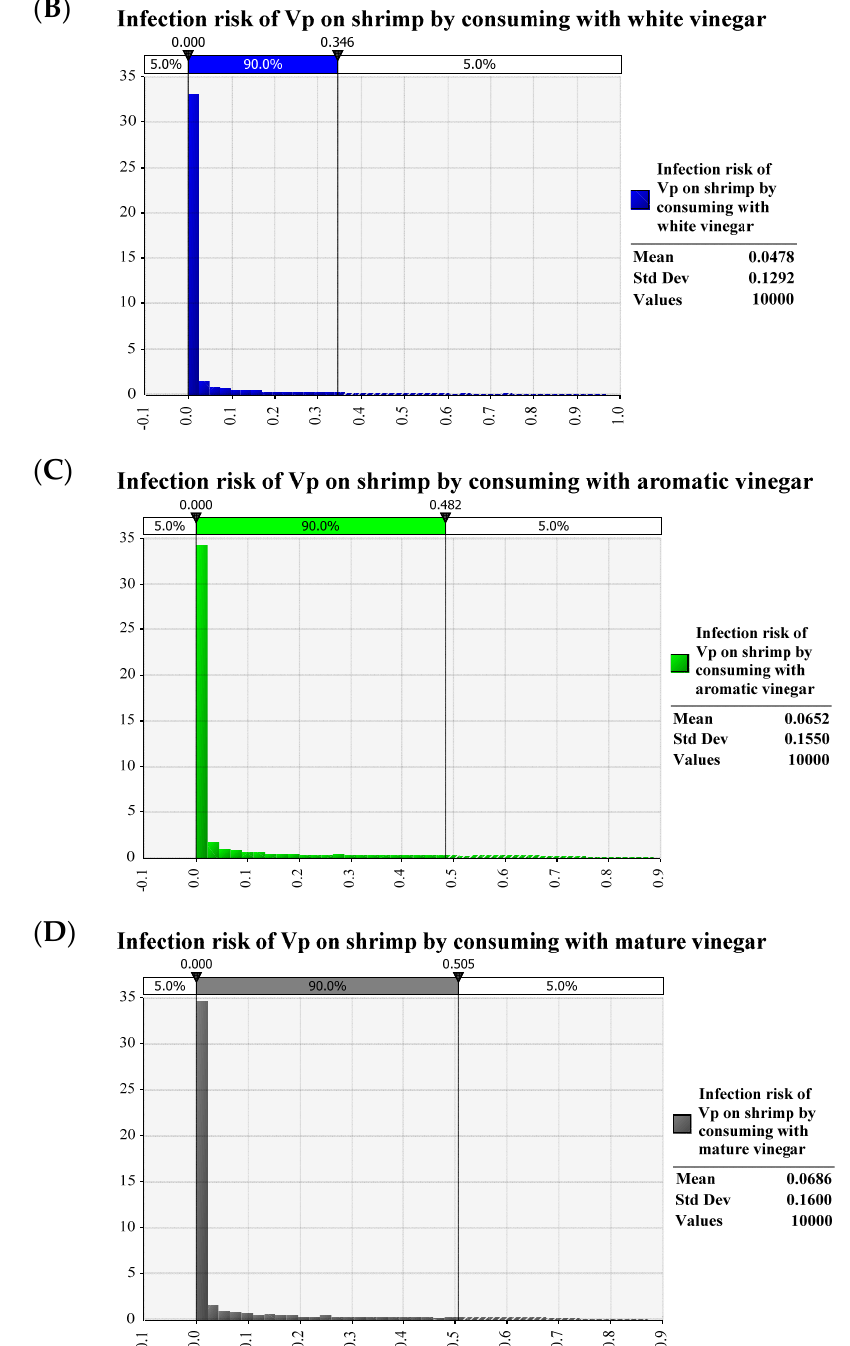
Figure 4. The infection risk of Vibrio parahaemolyticus on ready − to − eat shrimp by consuming without anything ( A ), and with white vinegar ( B ), aromatic vinegar ( C ) and mature vinegar ( D ).